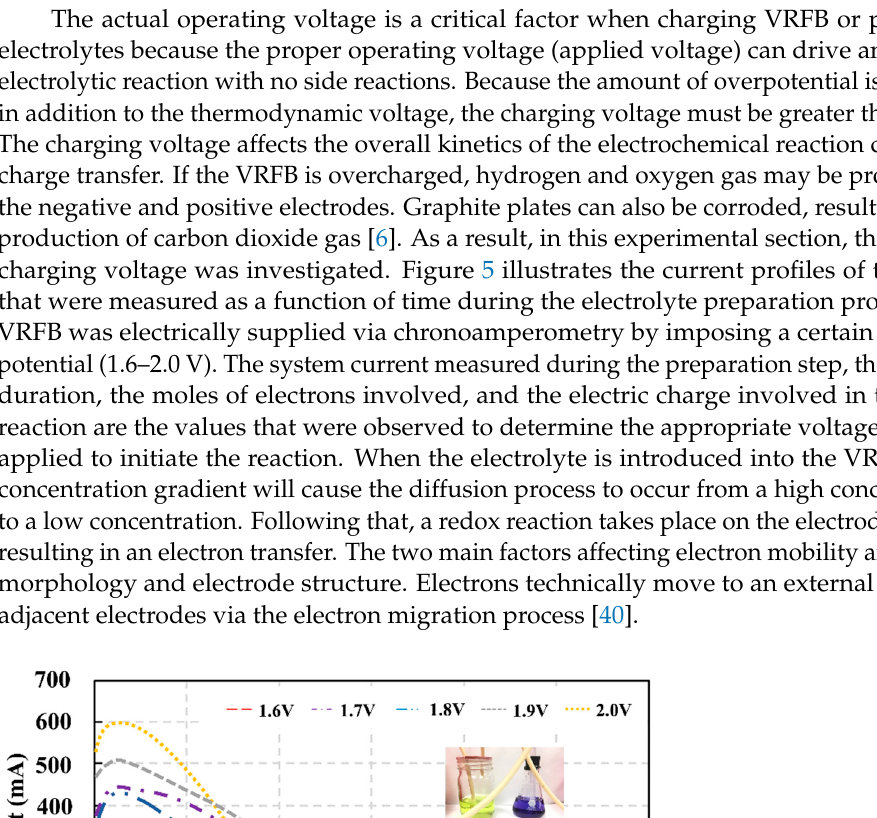
Figure 6. The moles of electrons occurring during redox as a function of time during the electrolyte preparation period .